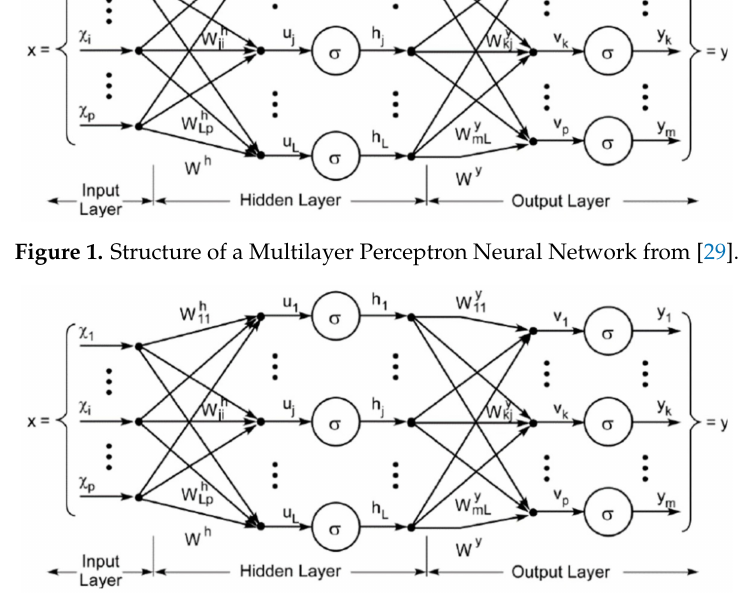
Figure 2. Proposed topology of the MLP model.